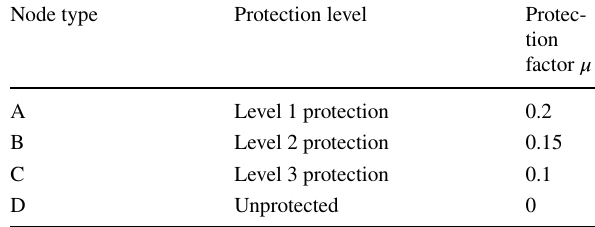
Table 1 Comparison table of node types and protection levels Node